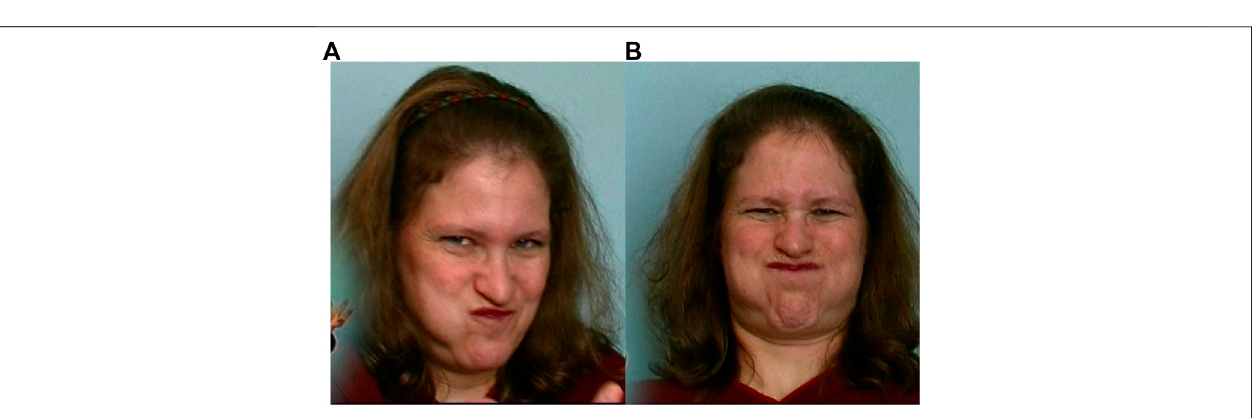
Frontiers in Communication |